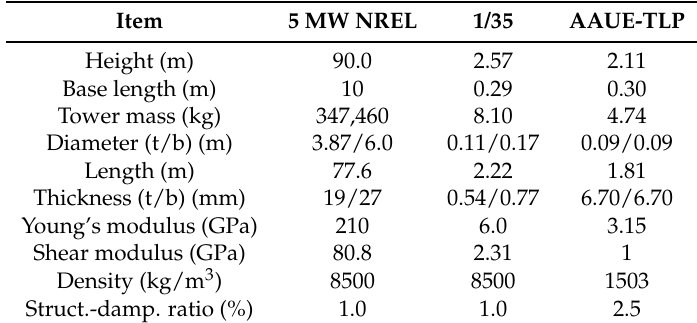
Table 2. Tower Properties.